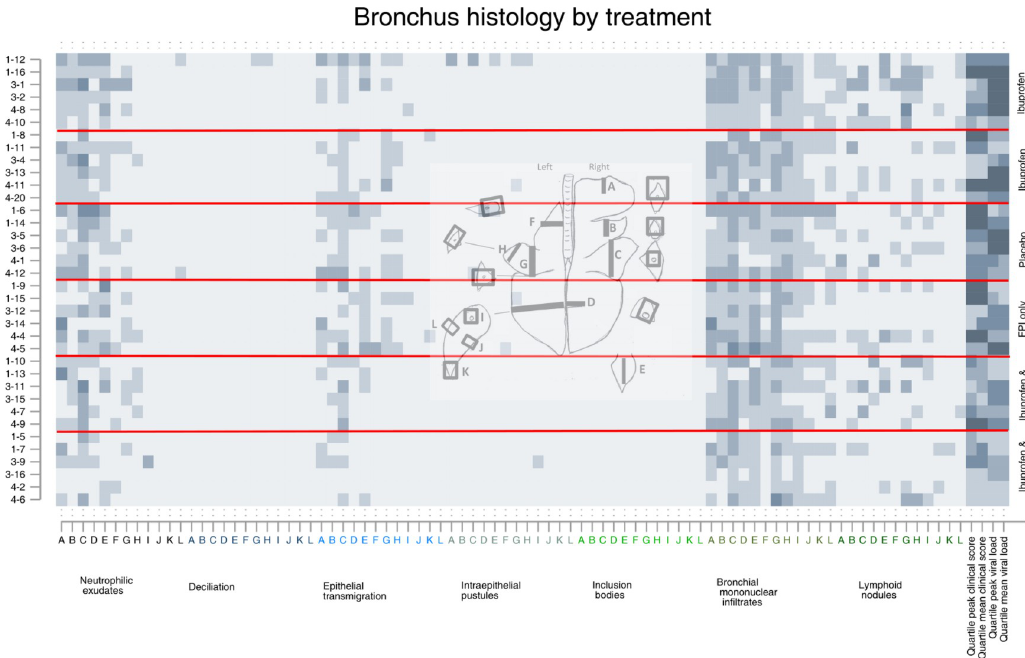
Fig 5. Bronchus histology findings by drug treatment group. Each row represents an individual calf, each letter represents a slide, the x-axis colors indicate a different specific histological finding. The shading of each pixel represents the severity of the finding on a scale of 0 (light) to 3 (darker). On the y-axis the first number represents the batch/replicate number, the number following the dash the ear tag for the individual calf. The horizontal red lines divide the treatment groups. The last four columns represent quartiles (first lightest, fourth darkest) of mean peak and clinical scores and mean peak viral loads measured by nasal swabs.